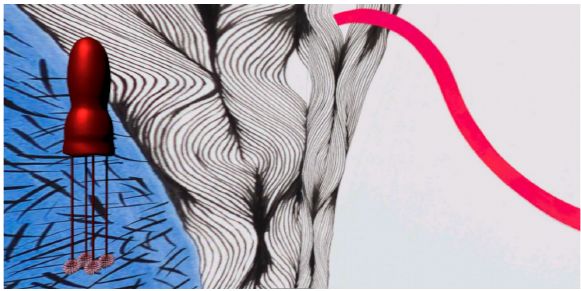
Figure 2. Entrance portal in AudioVirtualizer